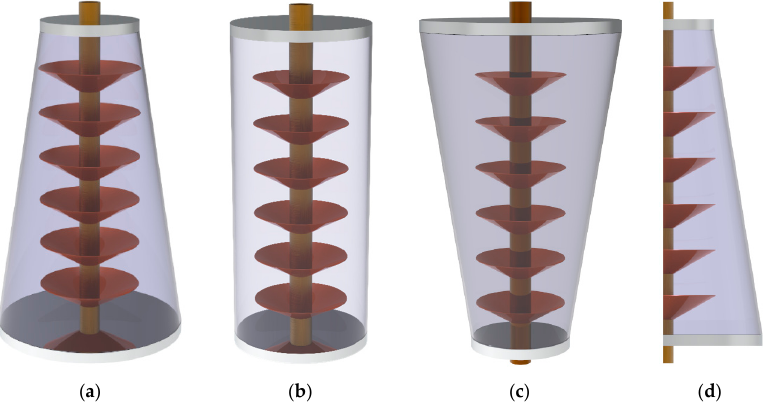
Figure 1. LHTES unit, ( a ) descending configuration, ( b ) normal configuration, ( c ) ascending configuration, and ( d ) 2D view of the LHTES unit. Table 1. Thermophysical properties of the coconut oil and the nanoadditives [24,25] .